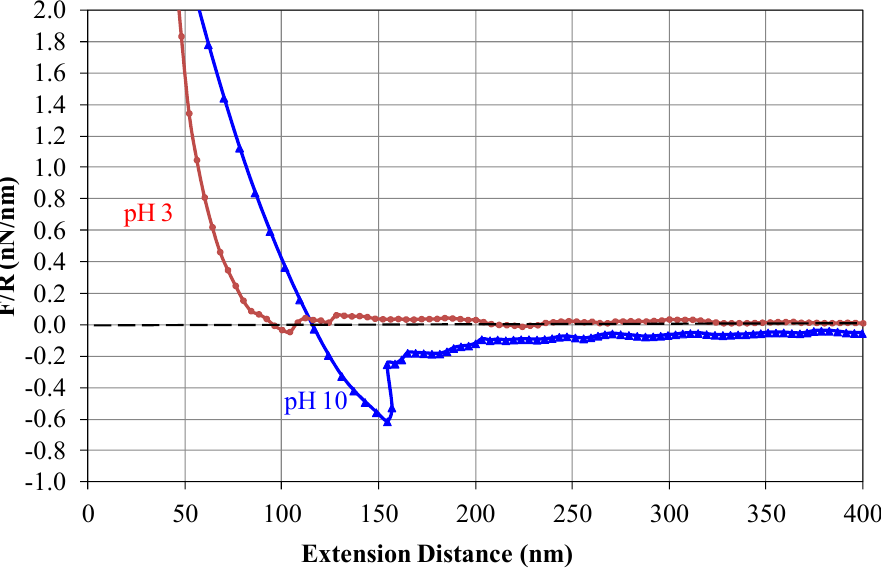
Figure 10. Retraction force curves on the PBI/PES membrane at pH 3 and at pH